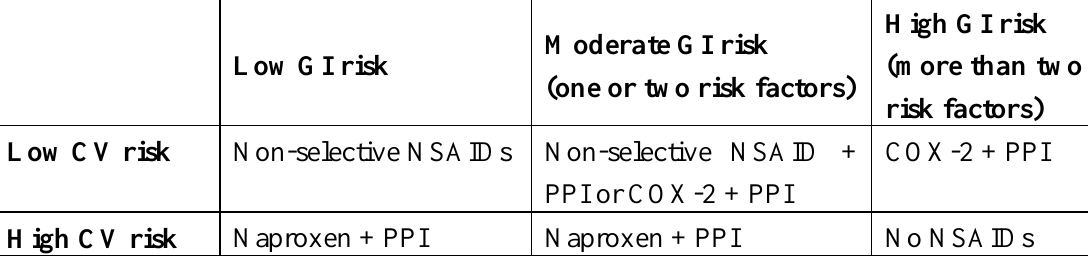
Table 1. Algorithm for NSAID prescription based on gastro-intestinal (GI) and cardiovascular (CV) risk factors. High GI risk Moderate GI risk Low GI risk (more than two (one or two risk factors) risk factors) COX-2 + PPI Low CV risk Non-selective NSAIDs Non-selective NSAID + PPI or COX-2 + PPI High CV risk Naproxen + PPI Naproxen + PPI No